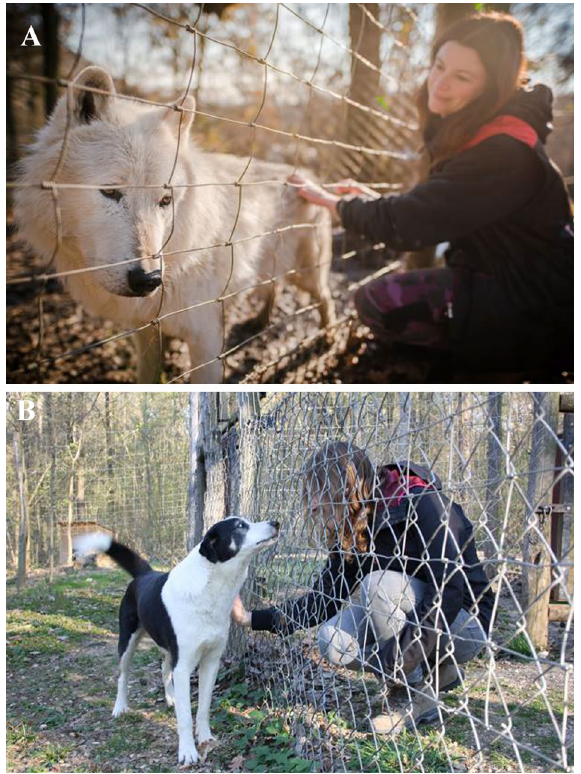
Figure 1. ( A , B ) Dyadic social interaction test in the animal’s home enclosure. Interaction test with a human partner with ( A ) a wolf, ( B ) a pack-living